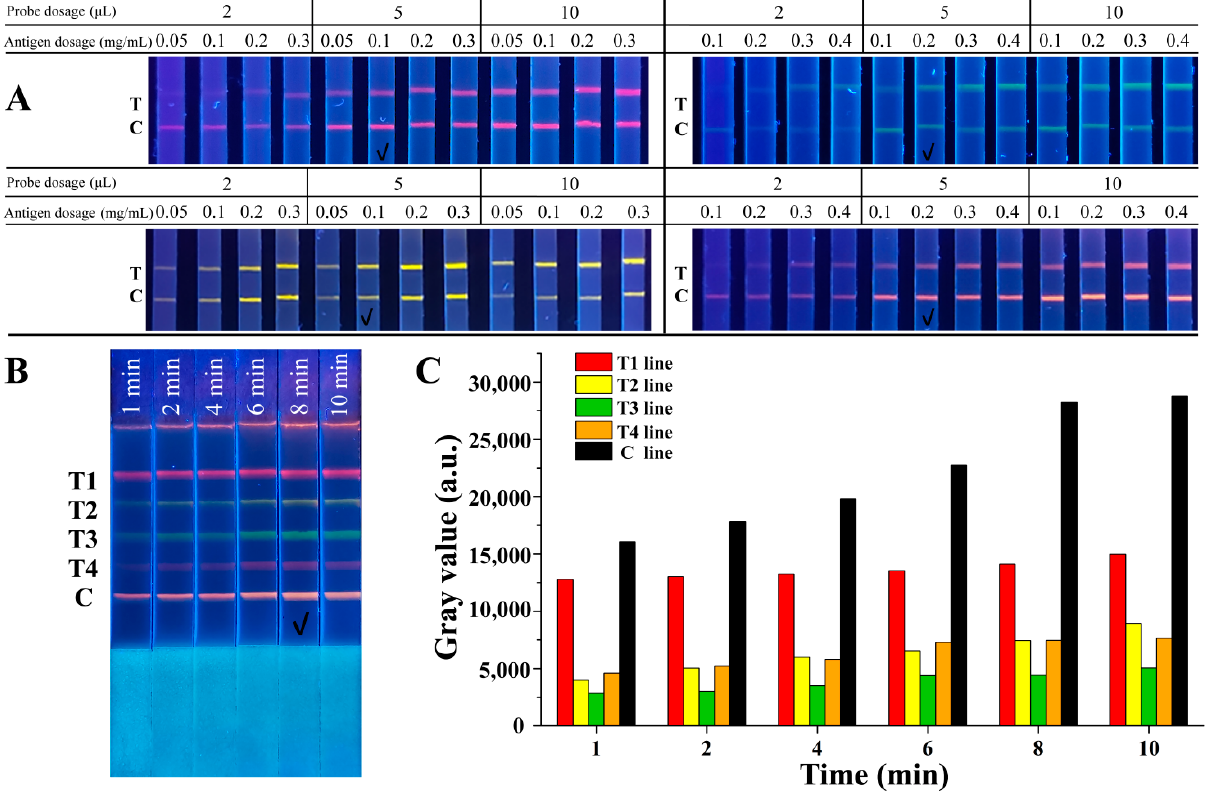
Figure 3. ( A ) Optimization of the concentrations of competitive antigen on T lines and amounts of QB-mAb probes, ( B ) optimization of immunoreaction time, and ( C ) gray values analysis of T and C lines. T1, T2, T3, T4, and C lines were 2-NPAOZ-BSA, 2-NPAHD-BSA, 2-NPSEM-BSA, 2-NPAMOZ-BSA, and rabbit anti-mouse IgG, respectively. The check mark indicated the optimal condition.